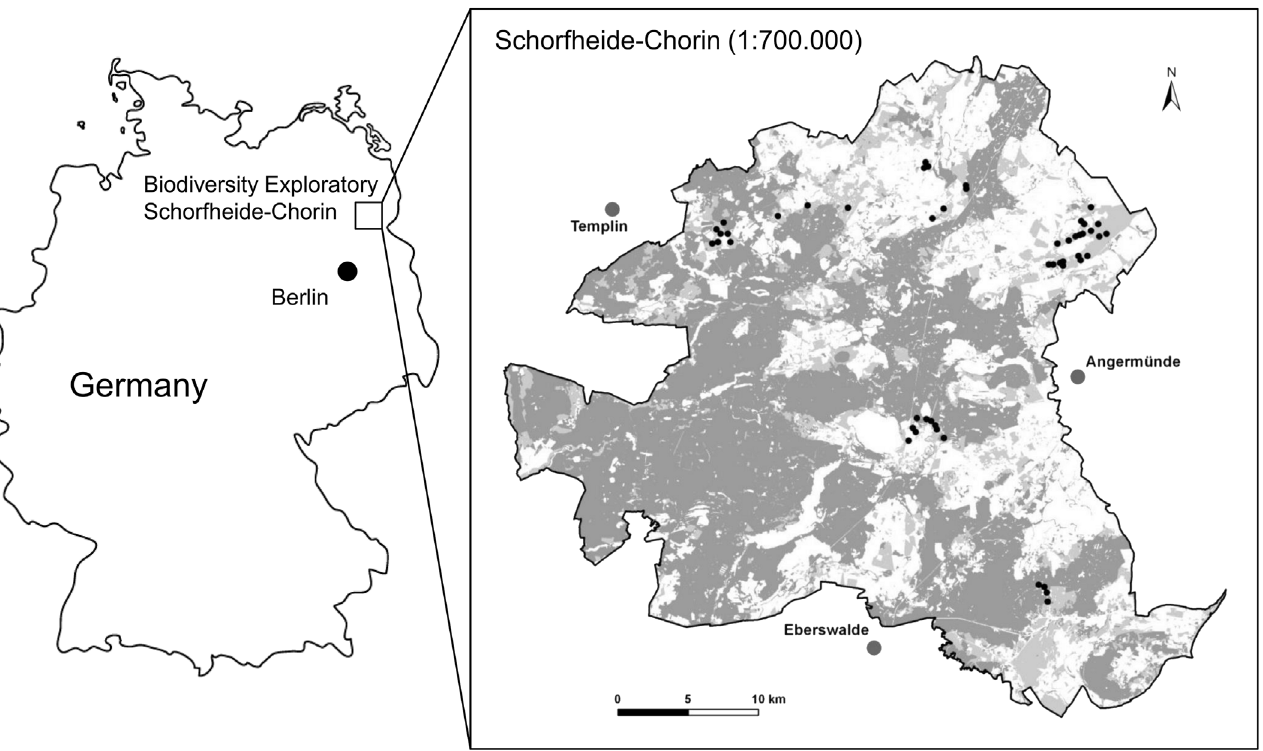
Fig 1. Location of the Biodiversity Exploratory Schorfheide-Chorin in Germany and a map of the Biosphere Reserve Schorfheide-Chorin. Dark grey areas indicate forest patches, light grey areas and white areas indicate agricultural fields or grassland areas. Black circles indicate the location of the 50 permanent recording sites in grassland where acoustical monitoring of bats took